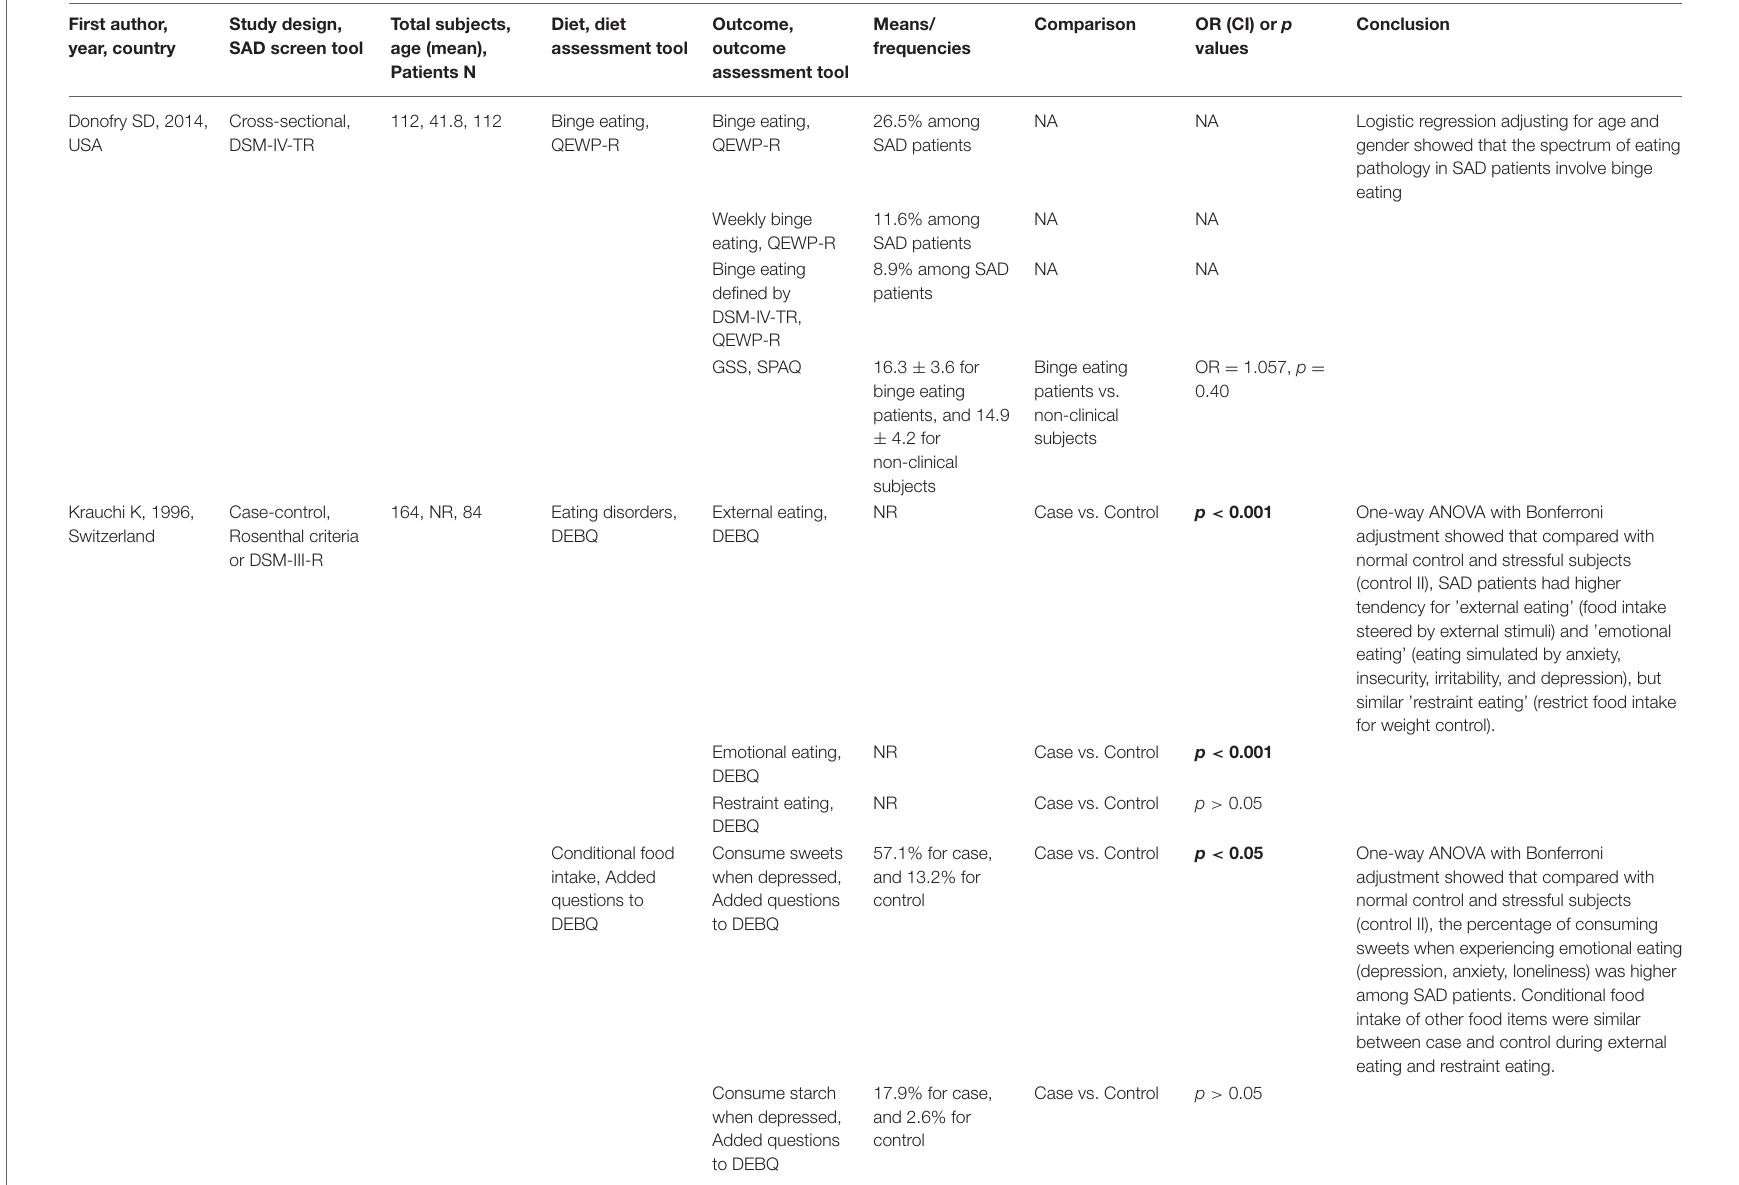
TABLE 2 | Characteristics of included studies evaluating the associations between eating behaviors and